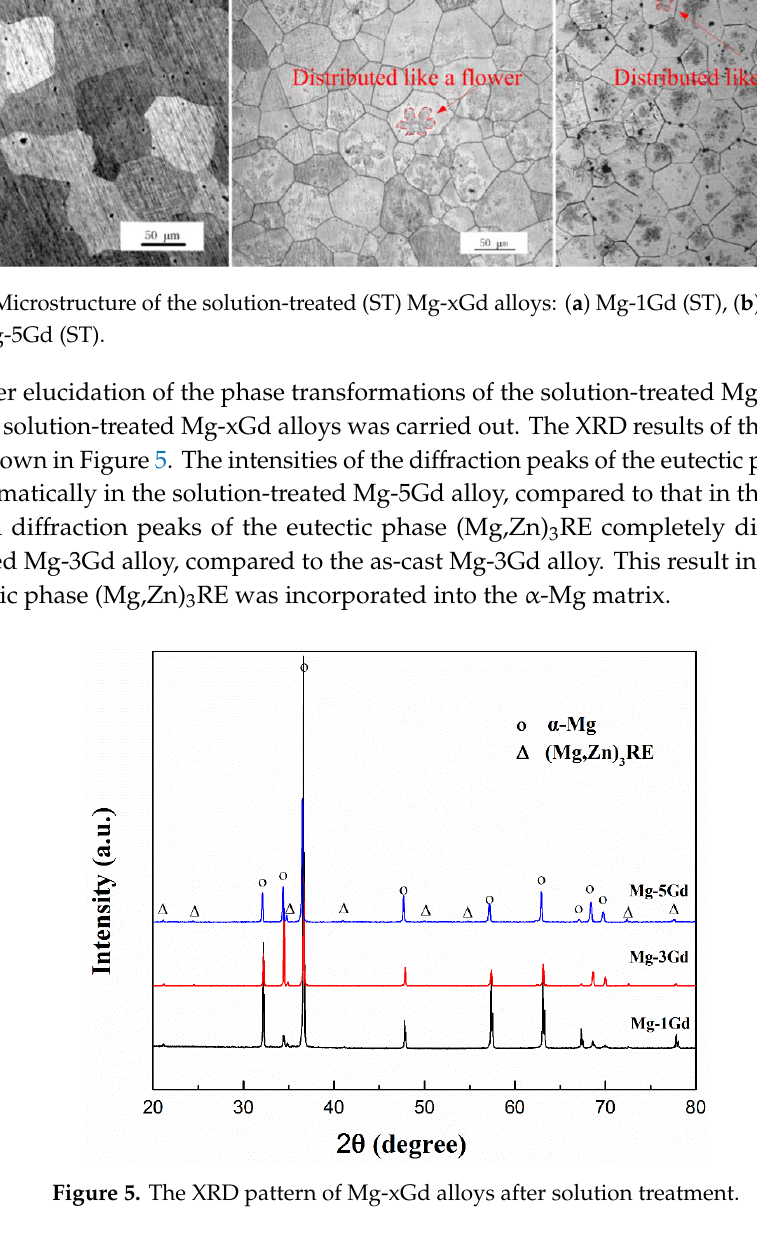
Figure 3. The X-ray Diffraction (XRD) pattern of the as-cast Mg-xGd alloys ( a ), phase comparison and corresponding ICCD cards ( b ).